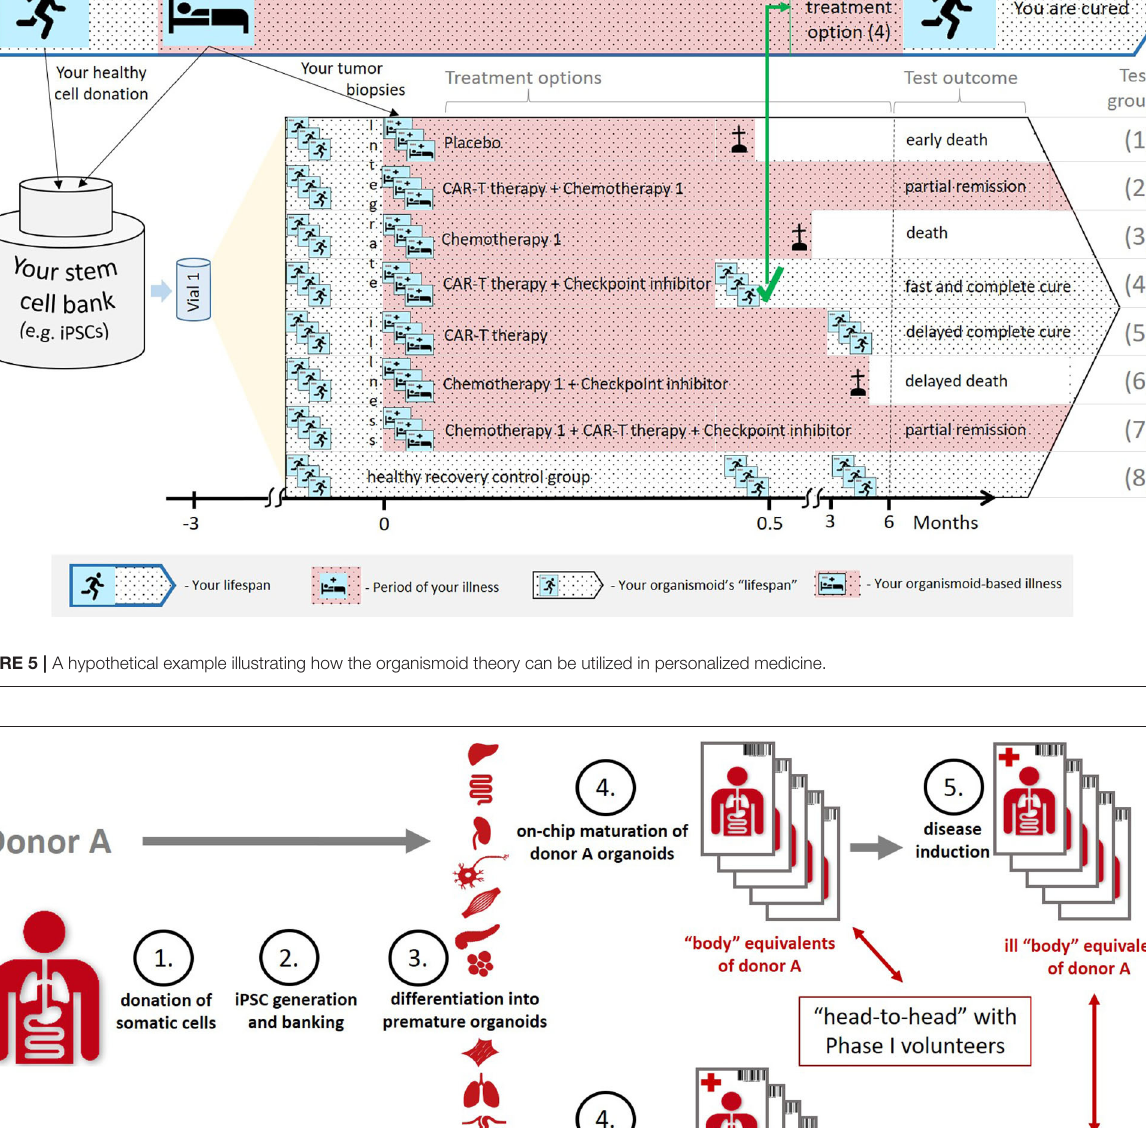
trials was sketched in 2018 by the Investigative Toxicology Leaders Forum